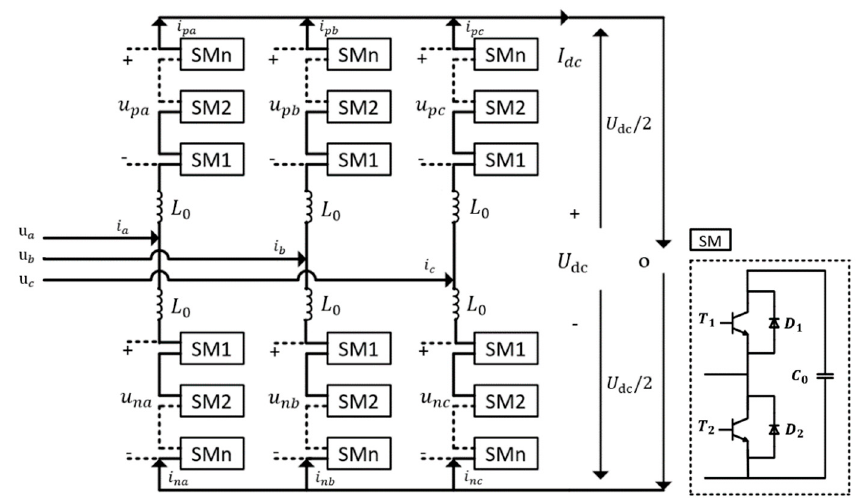
Figure 2. Topology structure of the MMC.